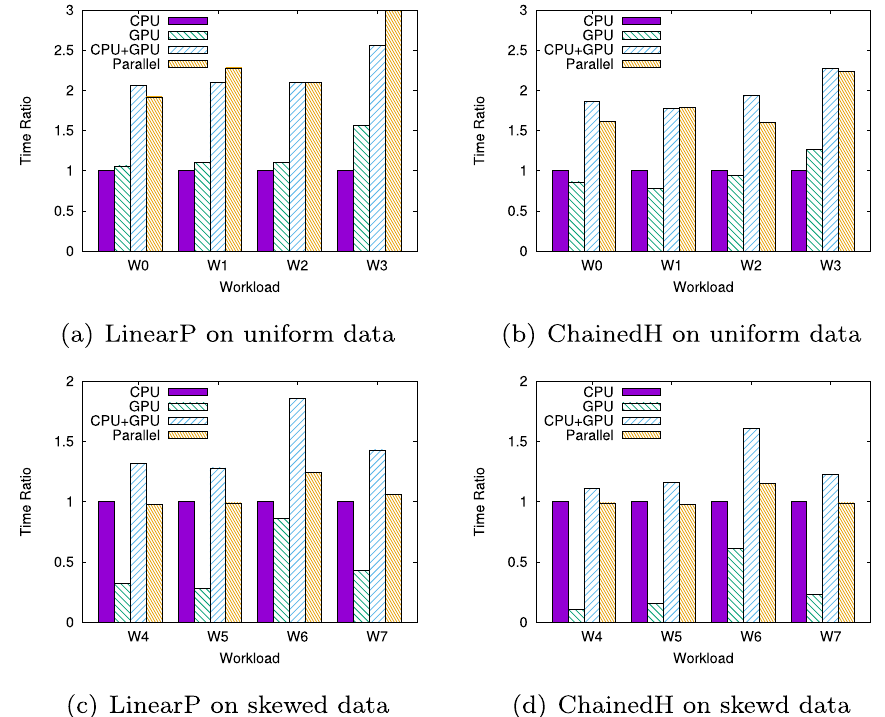
Fig. 15 Performance of the operator-level co-processing